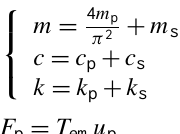
Figure 8. Physical model of the PE-SSA system (with friction) (Adriaens et al.,